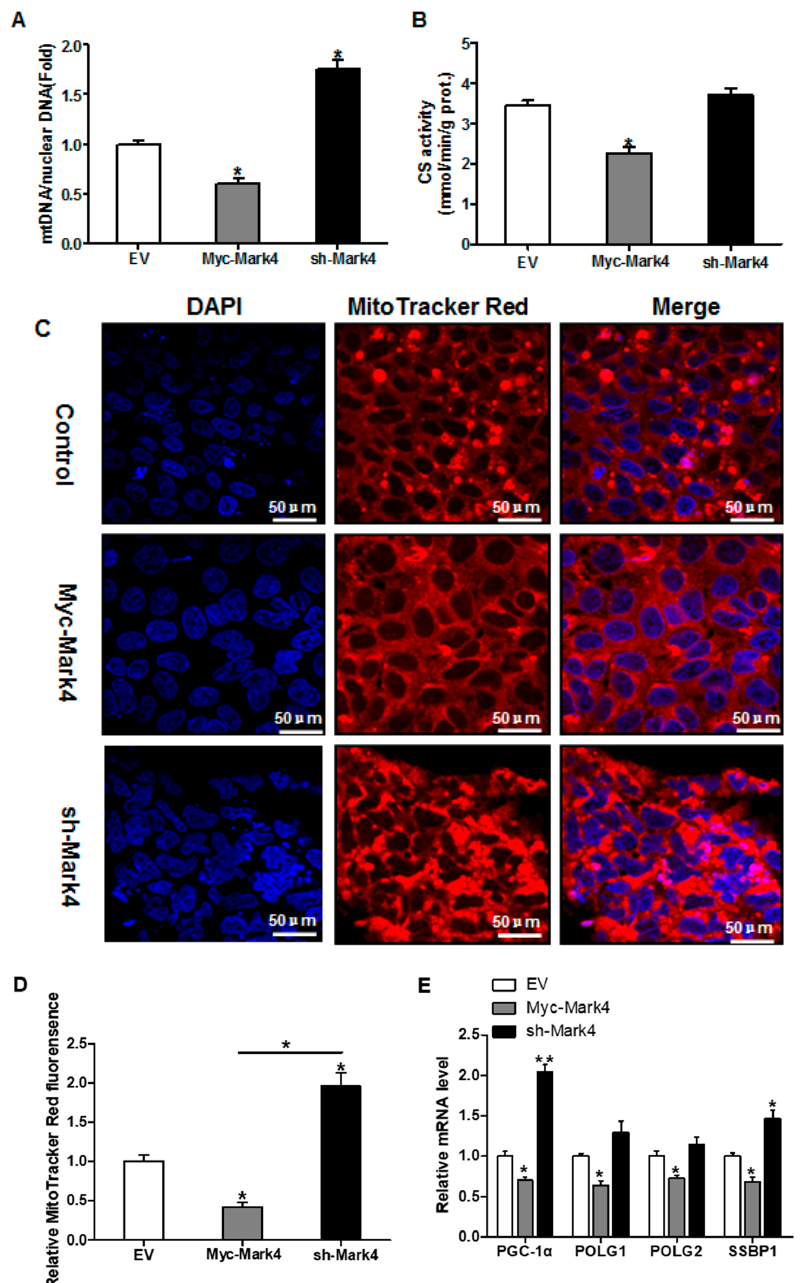
Figure 3. The effect of MARK4 on mitochondrial density in pig primary trophoblast cells challenged with 400 μ M NEFA. ( A , B ) Mitochondrial biogenesis was estimated by both mtDNA copy number ( A ) and CS activity ( B ) in primary trophoblast cells after transfection with Myc-MARK4 and sh- MARK4 for 48 h. Cells were then incubated with 400 μ M NEFA for 24 h ( n = 3); Representative visualization ( C ) and quantification ( D ) of MitoTracker Red staining for mitochondria after trans- fection with Myc-MARK4 and sh-MARK4 for 48 h in cytotrophoblasts. Before staining, cells were incubated with 400 μ M NEFA for 24 h ( n = 3). Scale bar: 50 μ m; ( E ) mRNA levels of genes implicated in mitochondrial biogenesis and mtDNA replication ( n = 3). Results were expressed as fold change relative to the values of control cells set to 1 unit. Values are expressed as mean ± SEM. ** p < 0.01; *